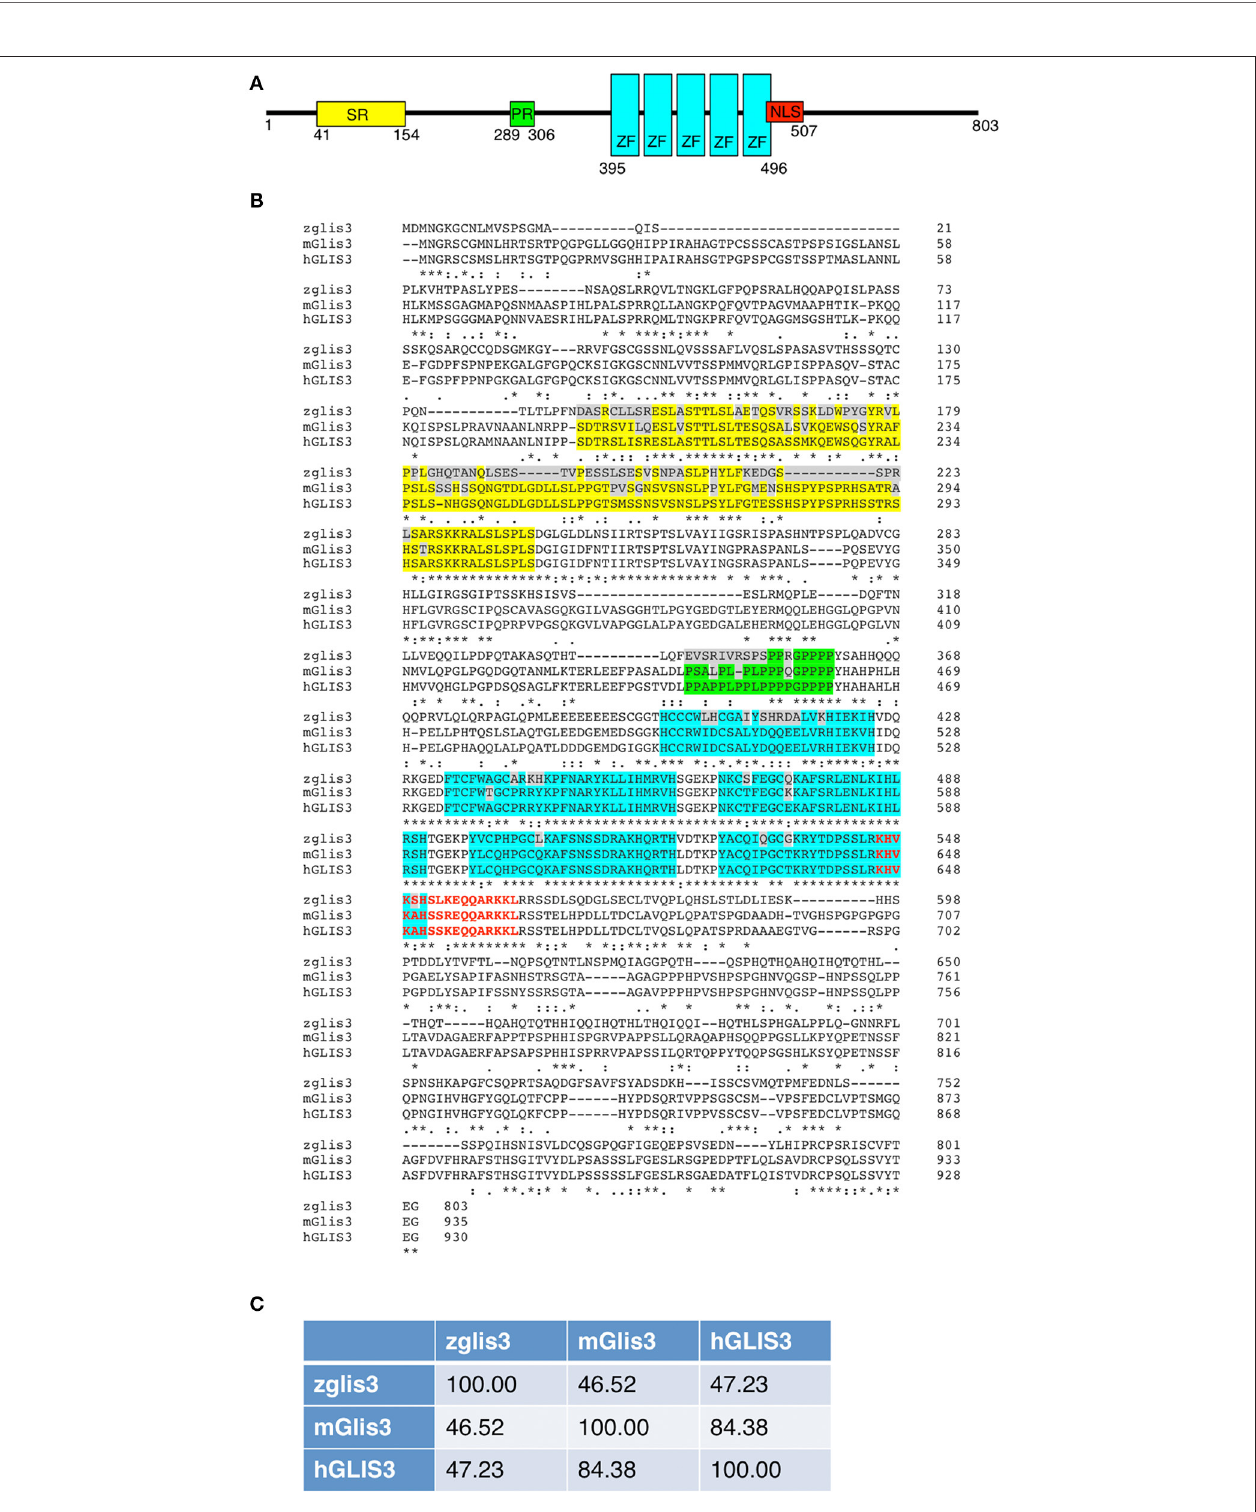
Frontiers in Endocrinology | www.frontiersin.org